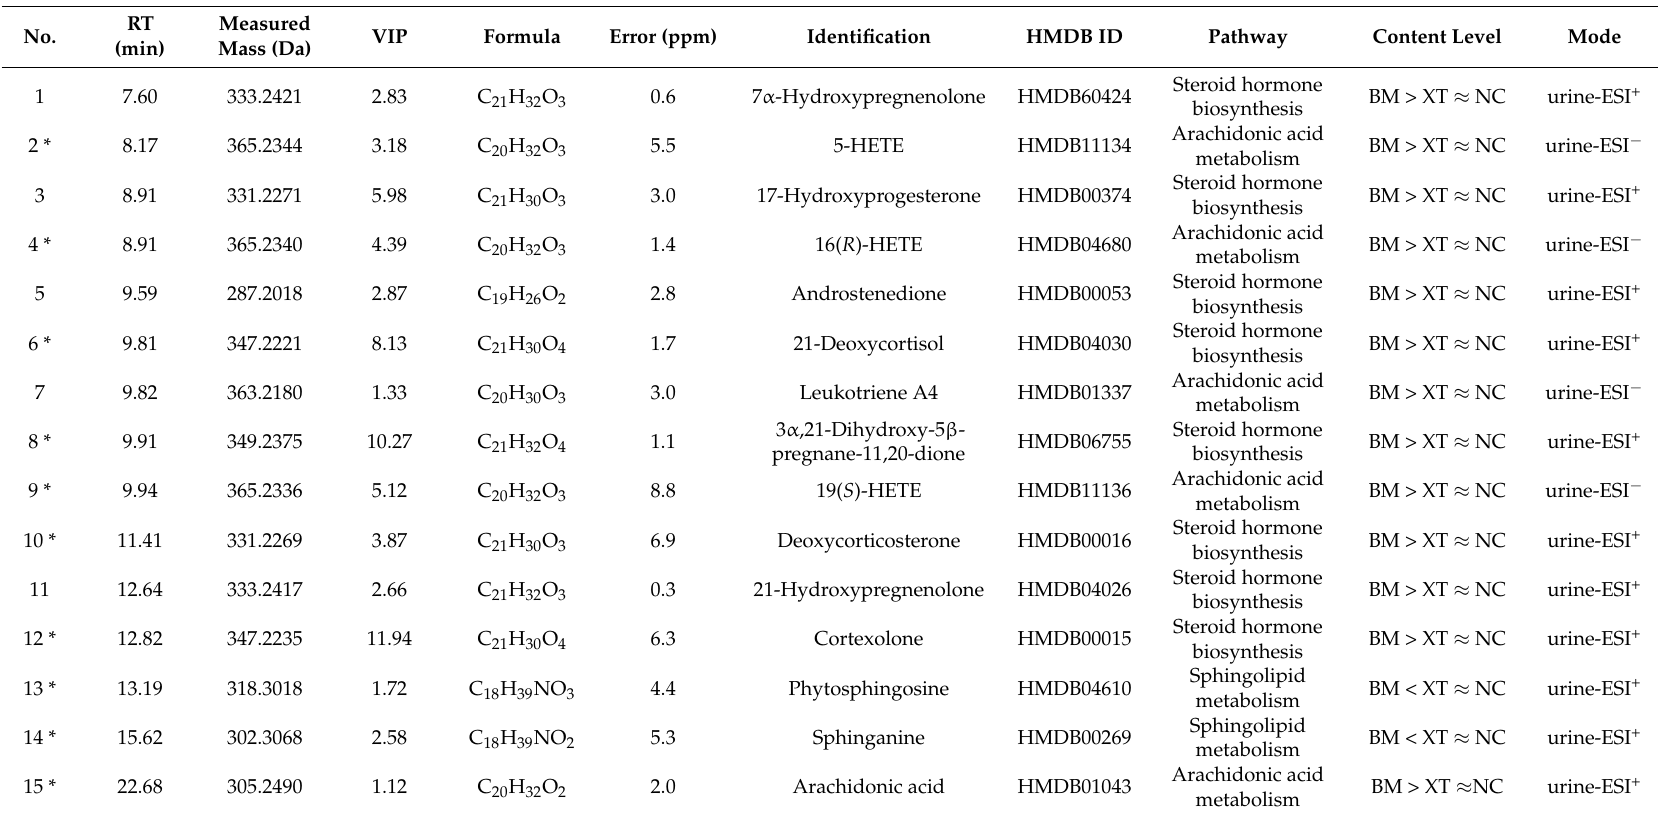
Table 3. Identification results of potential markers in urine and